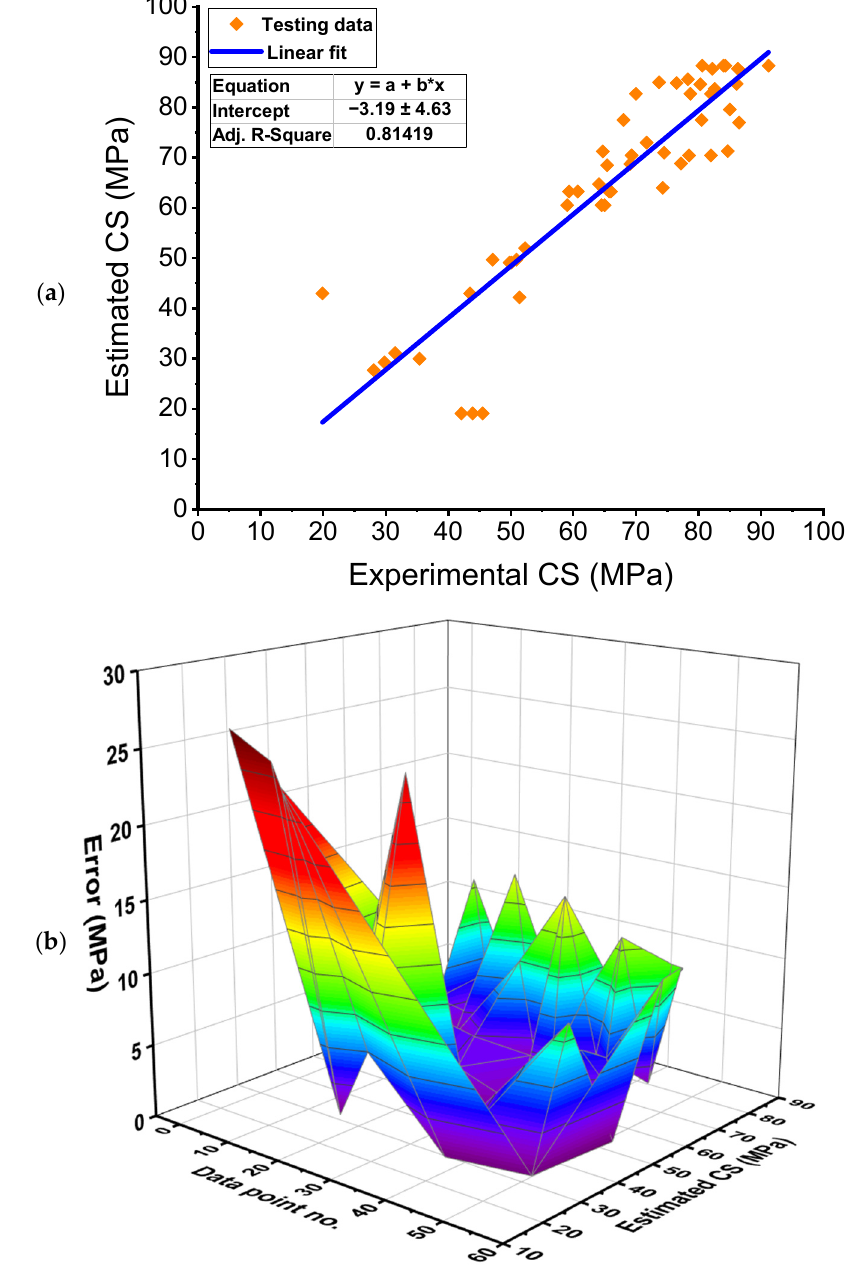
Figure 7. Gradient boosting model: ( a ) Relation between real and anticipated outcomes; ( b ) Disper- sion of anticipated results and errors. 𝐸𝑟𝑟𝑜𝑟 = |𝐸𝑥𝑝𝑒𝑟𝑖𝑚𝑒𝑛𝑡𝑎𝑙 𝑟𝑒𝑠𝑢𝑙𝑡 − 𝐸𝑠𝑡𝑖𝑚𝑎𝑡𝑒𝑑 𝑟𝑒𝑠𝑢𝑙𝑡|.